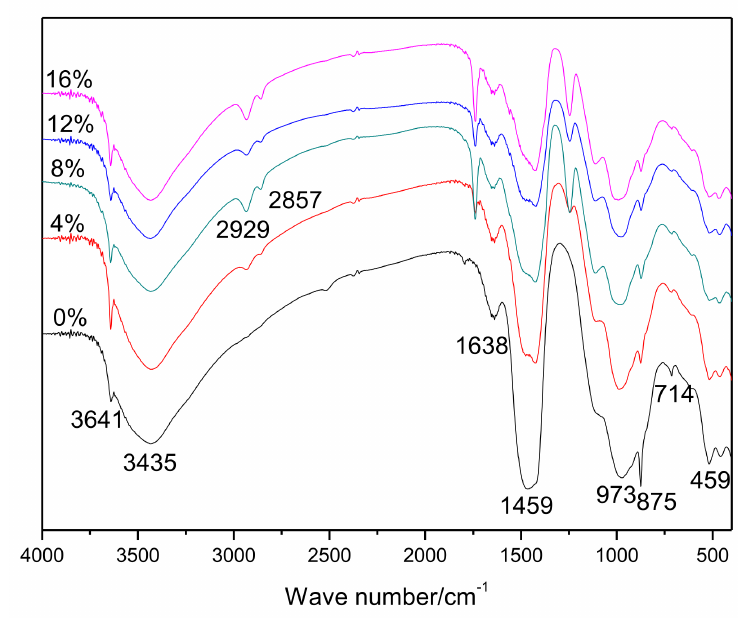
Figure 2. FT-IR spectra of 28-day cured cement